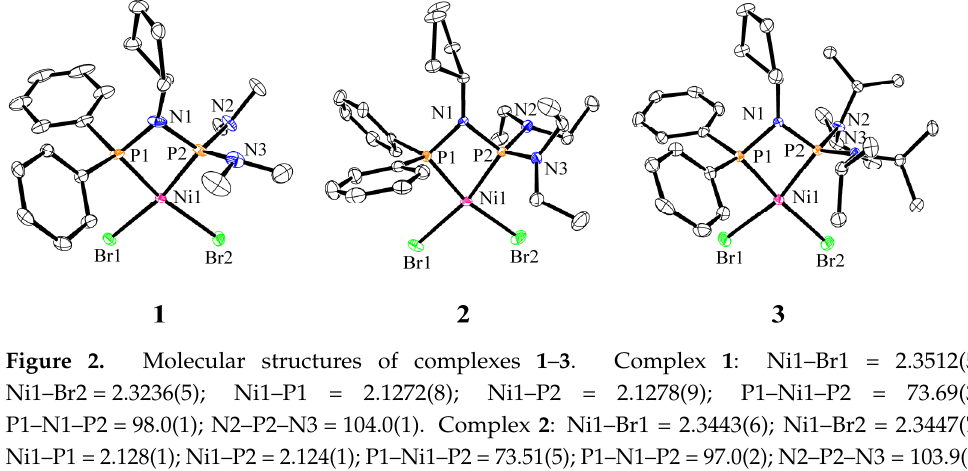
Figure 2. Molecular structures of complexes 1 – 3 . Complex 1 : Ni1–Br1 = 2.3512(5); Ni1–Br2 =